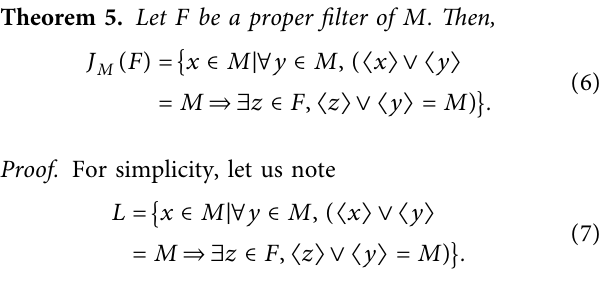
and its filter lattice F ( M 1